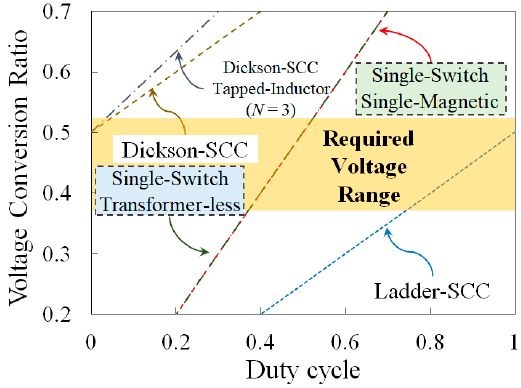
Figure 7. Voltage conversion ratios of five integrated PWM converters.